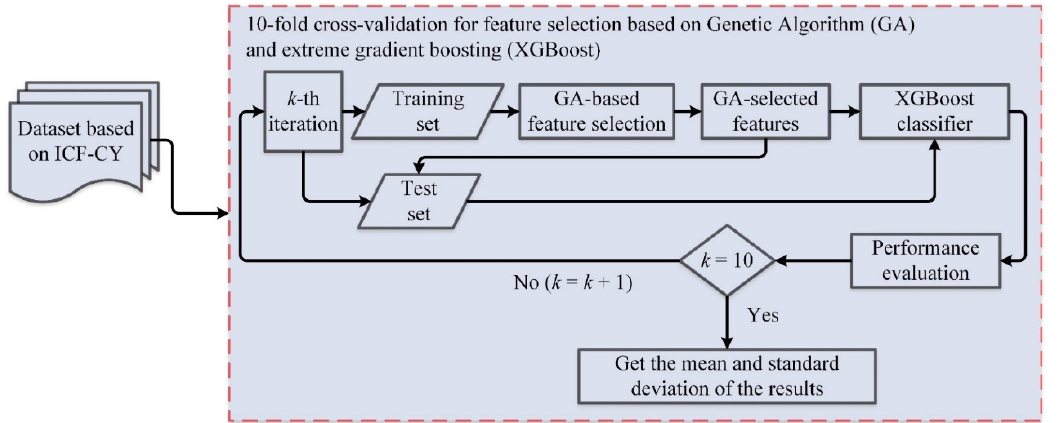
Figure 1. The proposed genetic algorithms (GA) and extreme gradient boosting (XGBoost) for self-care prediction.